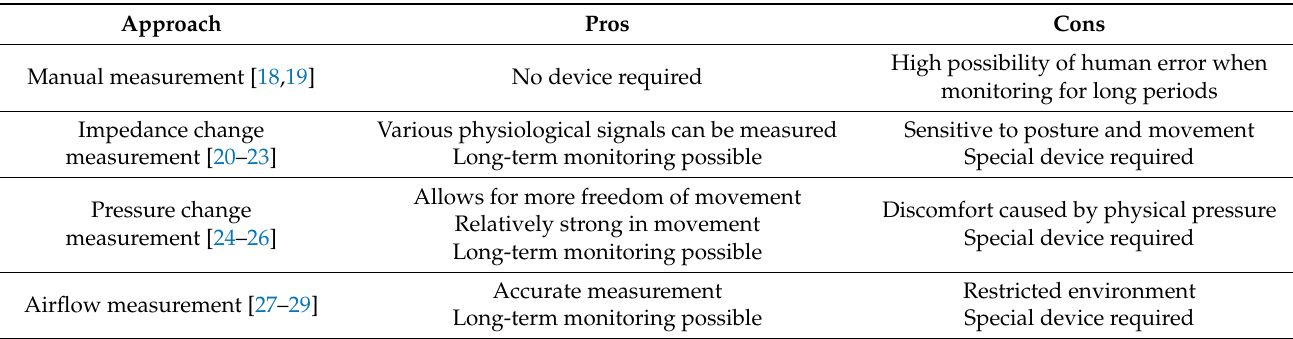
Table 1. Pros and cons of existing respiration measurement